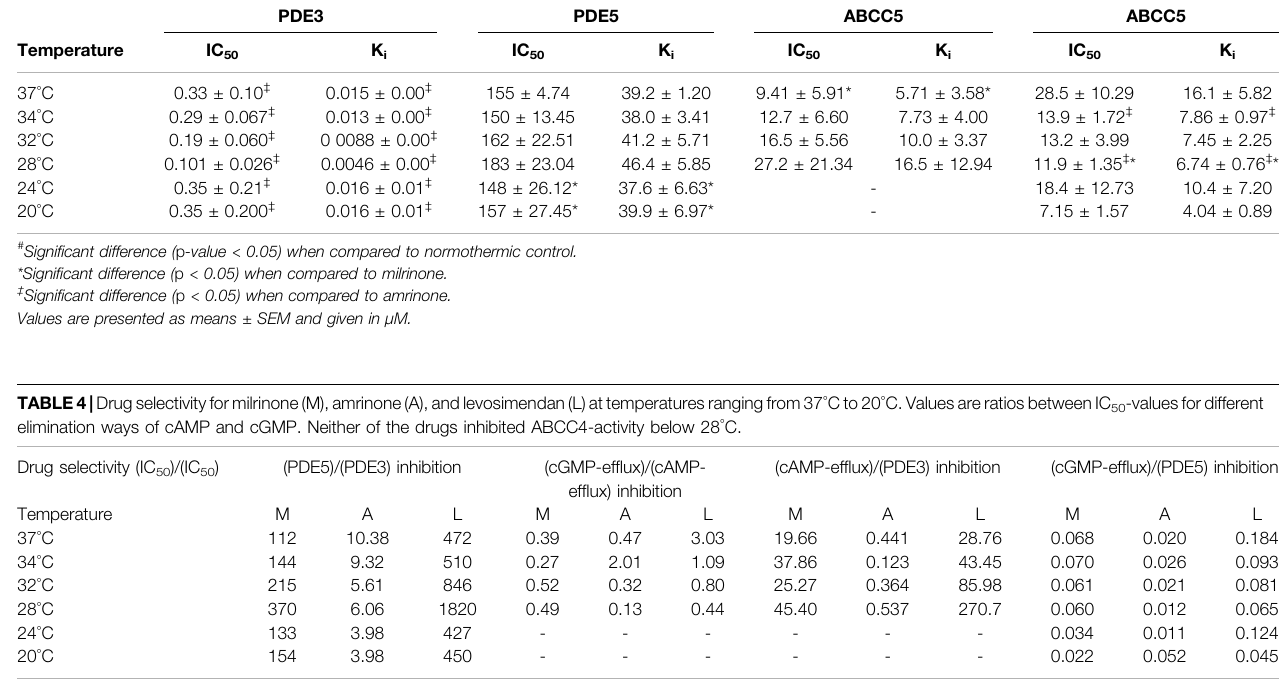
TABLE 3 | IC 50 and K i values for inhibition of PDE3, PDE5, ABCC4, and ABCC5 at temperatures ranging from 37 ° C to 20 ° C. Levosimendan